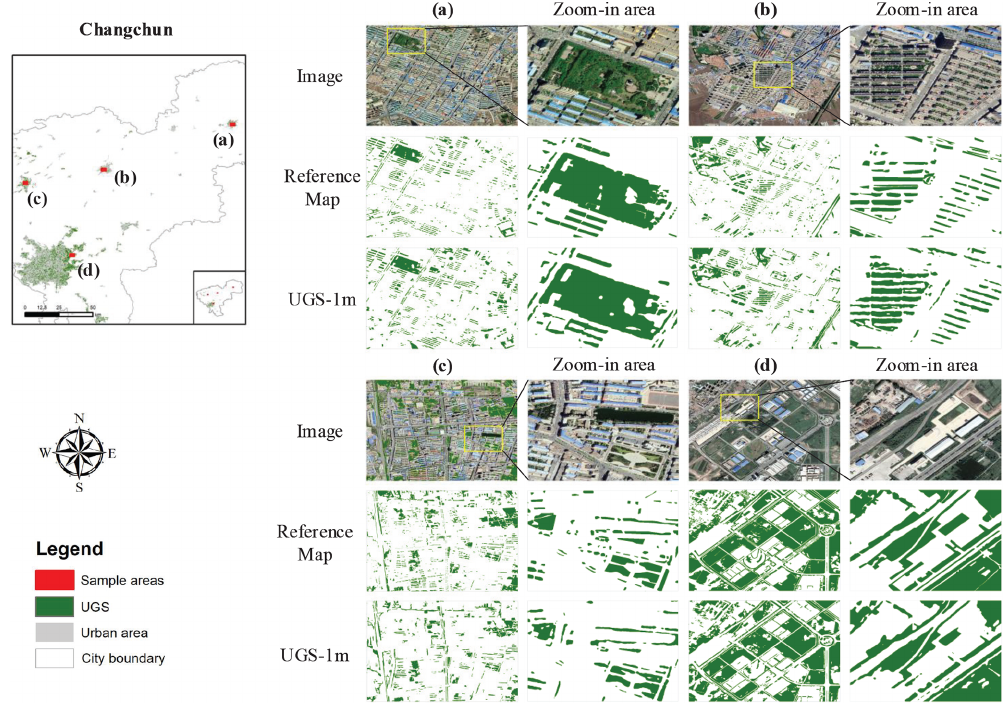
Figure 13. Qualitative analysis in UGS-1m, with a case study in Changchun city. Panels (a) – (d) are four example areas collected from Changchun. Images are from © Google Earth 2020.